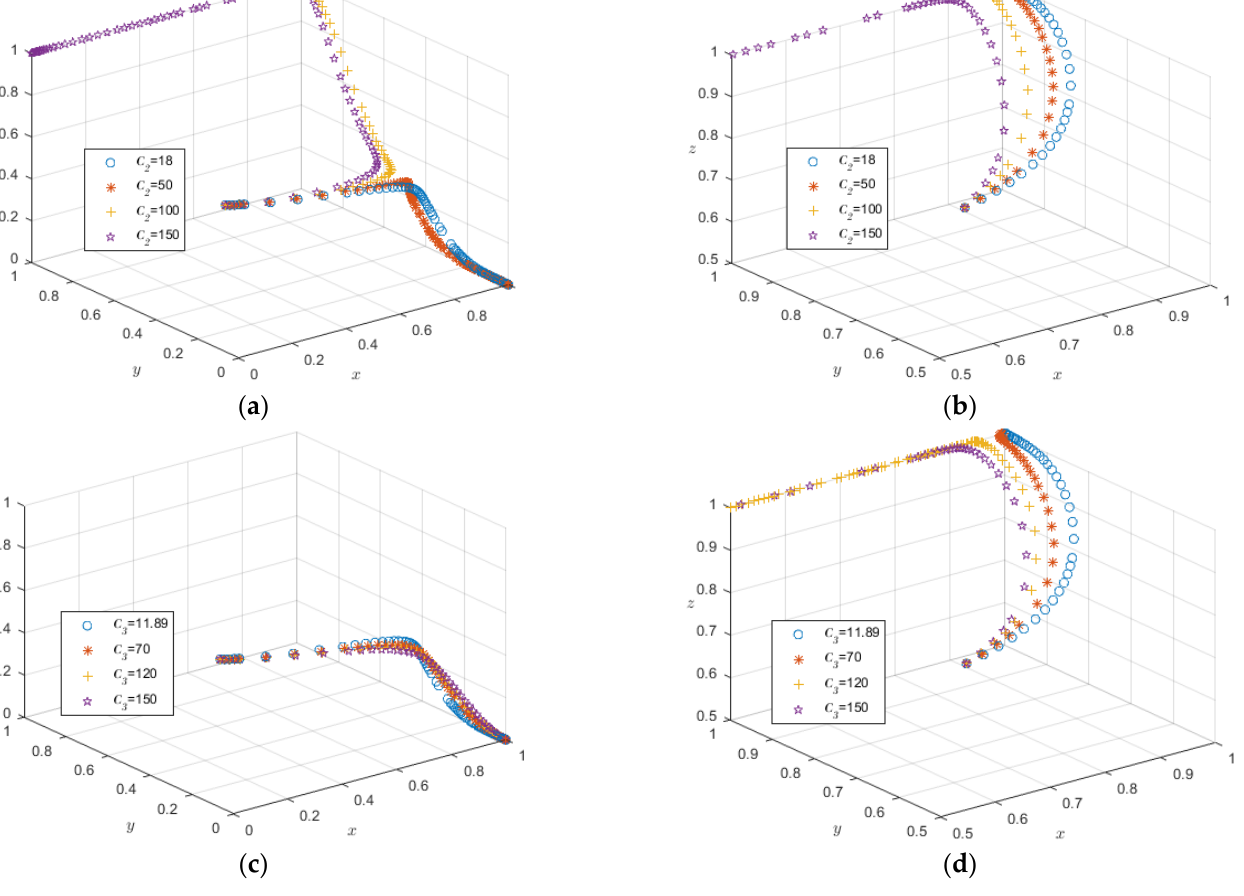
Figure 8. The evolution path under different incentive dedicated funds: ( a ) System A with (x 0 , y 0 , z 0 ) = (0.32, 0.48, 0.4); ( b ) System B with (x 1 , y 1 , z 1 ) = (0.7, 0.7, 0.7). The evolution path under different production trusteeship subsidies: ( c ) System A with (x 0 , y 0 , z 0 ) = (0.32, 0.48, 0.4); ( d ) System B with (x 1 , y 1 , z 1 ) = (0.7, 0.7, 0.7).